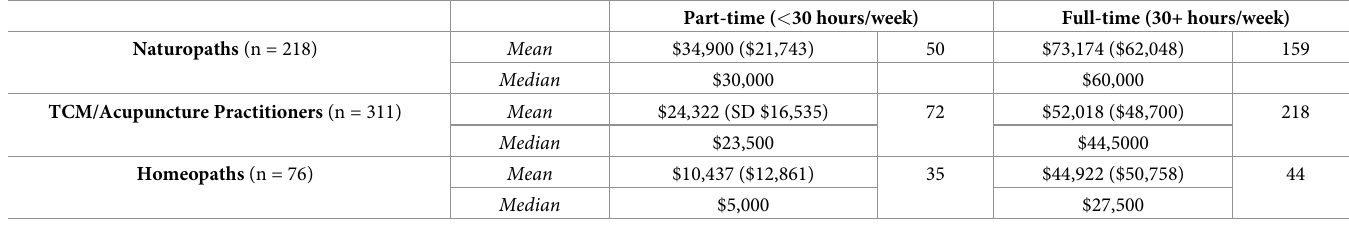
Table 5. Income breakdown by part- and full-time